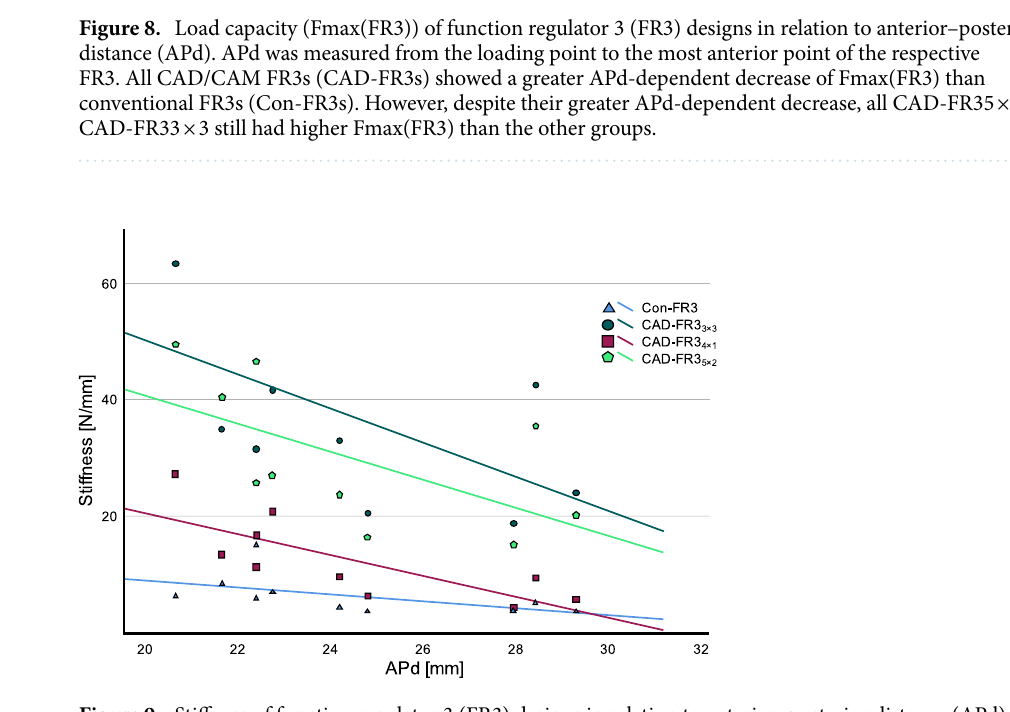
Figure 9. Stiffness of function regulator 3 (FR3) designs in relation to anterior–posterior distance (APd). As observed for load capacity (Fmax(FR3)), all CAD/CAM FR3s (CAD-FR3s) showed a greater APd-dependent decrease of stiffness than conventional FR3s